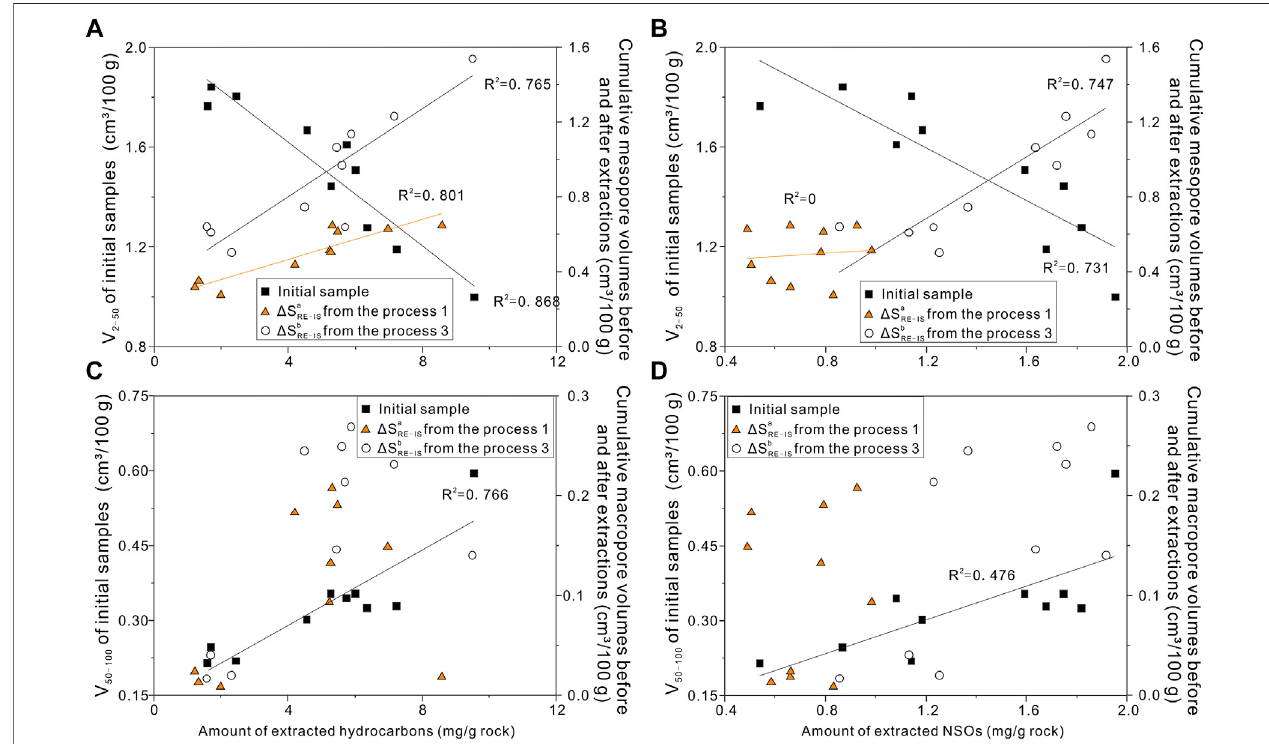
FIGURE 9 | (A) Amount of hydrocarbons vs. mesopore volumes in the initial samples and cumulative surface areas, respectively; (B) Amount of NSOs vs. mesopore volumes in the initial samples and cumulative surface areas, respectively; (C) Amount of hydrocarbons vs. macropore volumes in the initial samples and cumulative surface areas, respectively; (D) Amount of NSOs vs. macropore volumes in the initial samples and cumulative surface areas,